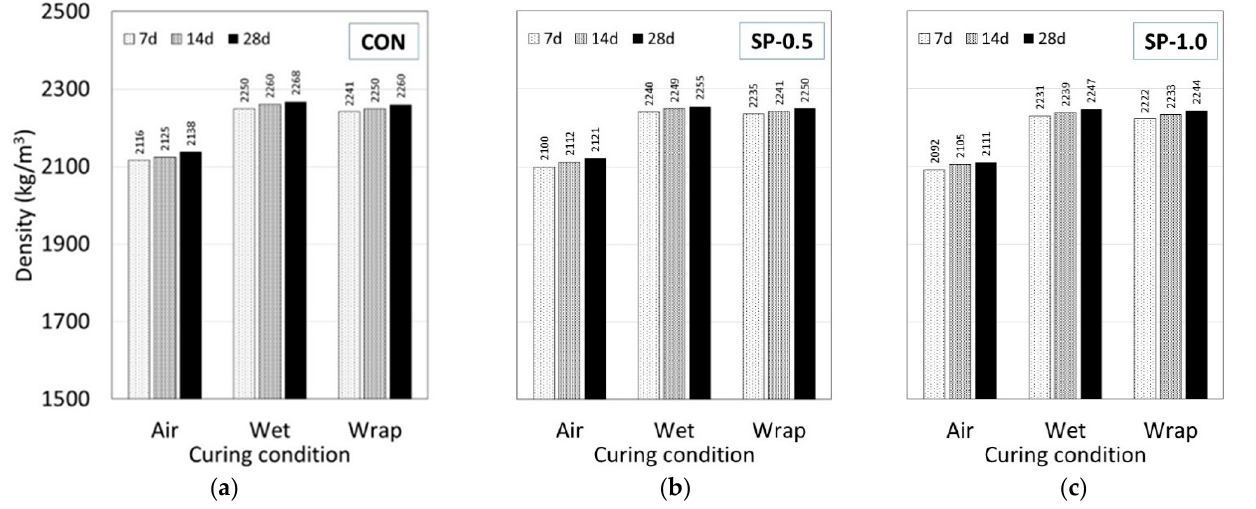
Figure 3. Dry density of ( a ) CON, ( b ) SP-0.5, and ( c ) SP-1.0 at different curing durations and con- ditions.